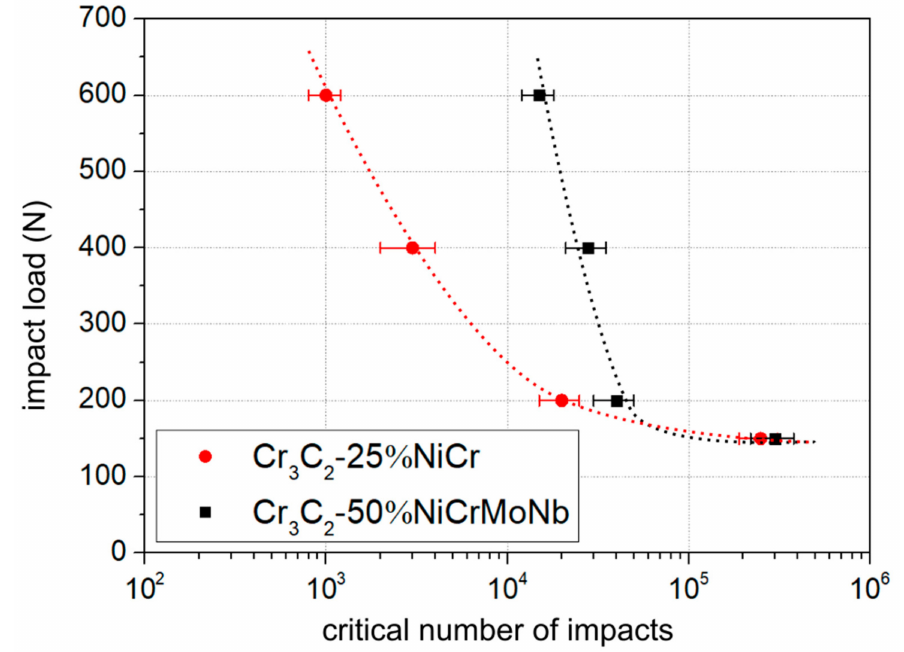
Figure 9. Dependence of the critical number of impacts on the used impact load. Comparison of the Cr 3 C 2 -25%NiCr and Cr 3 C 2 -50%NiCrMoNb coatings. Dotted lines were added as a visual